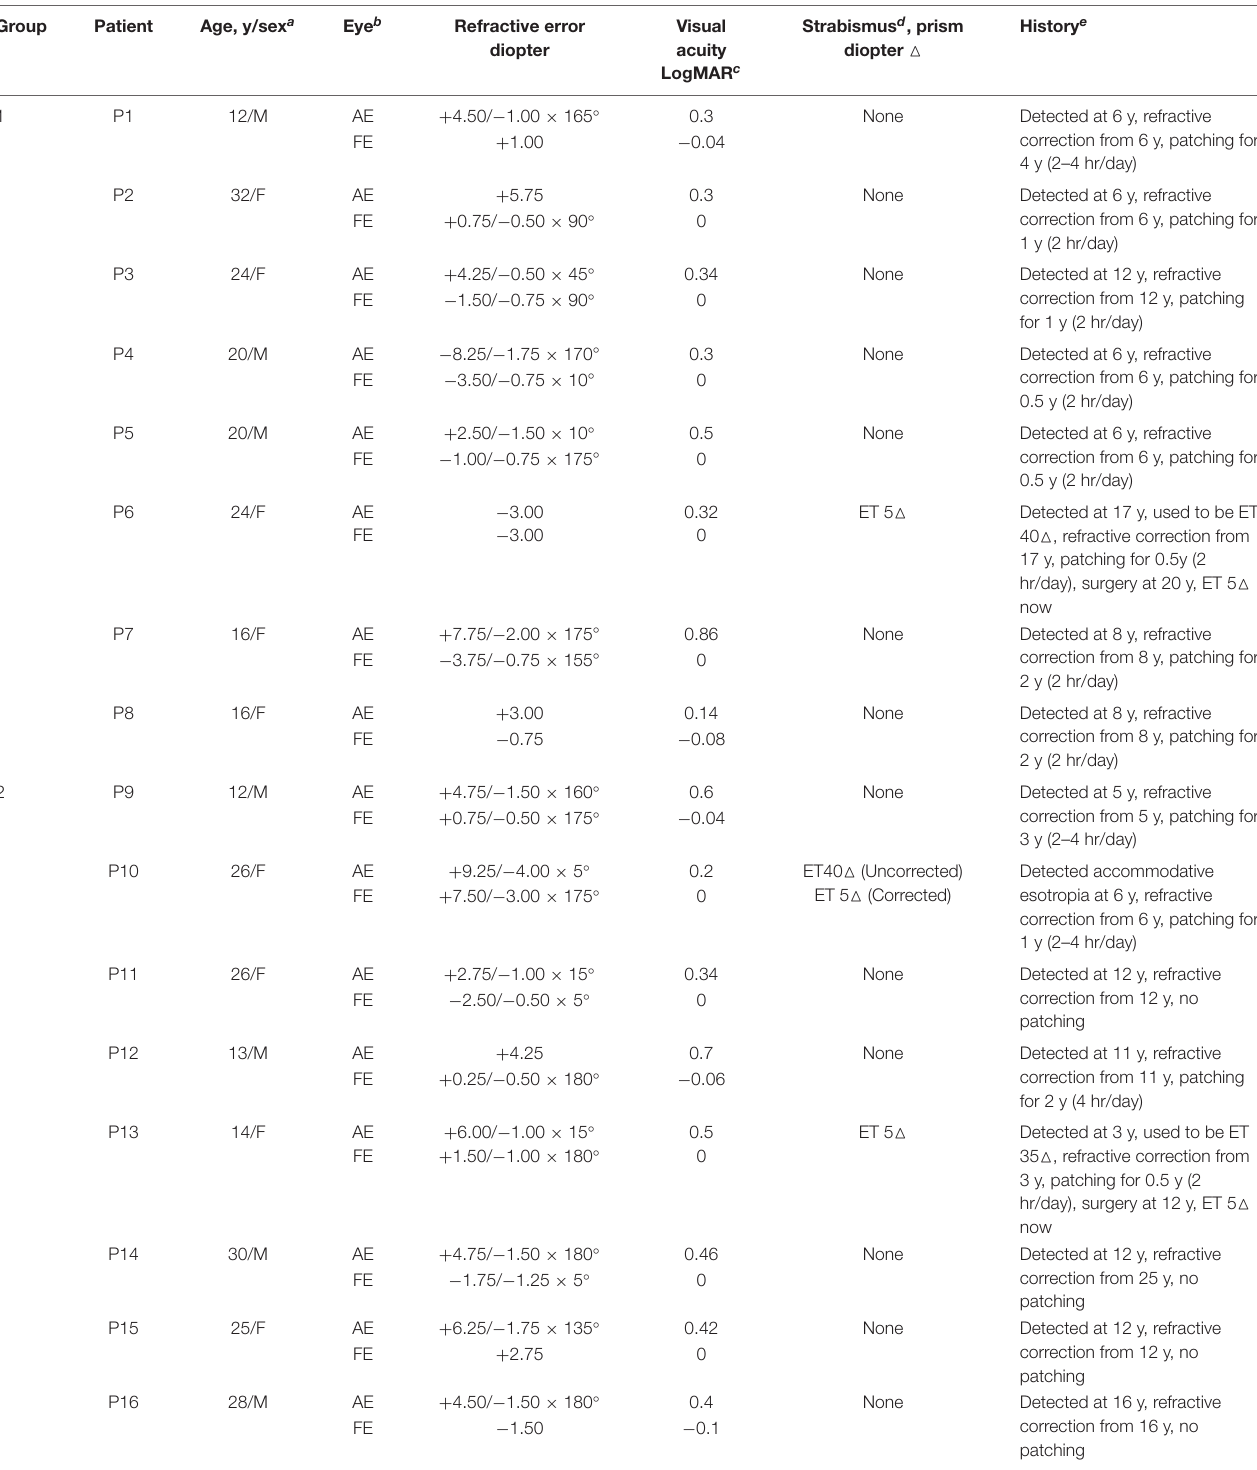
TABLE 1 | Clinical details of all participants by group.